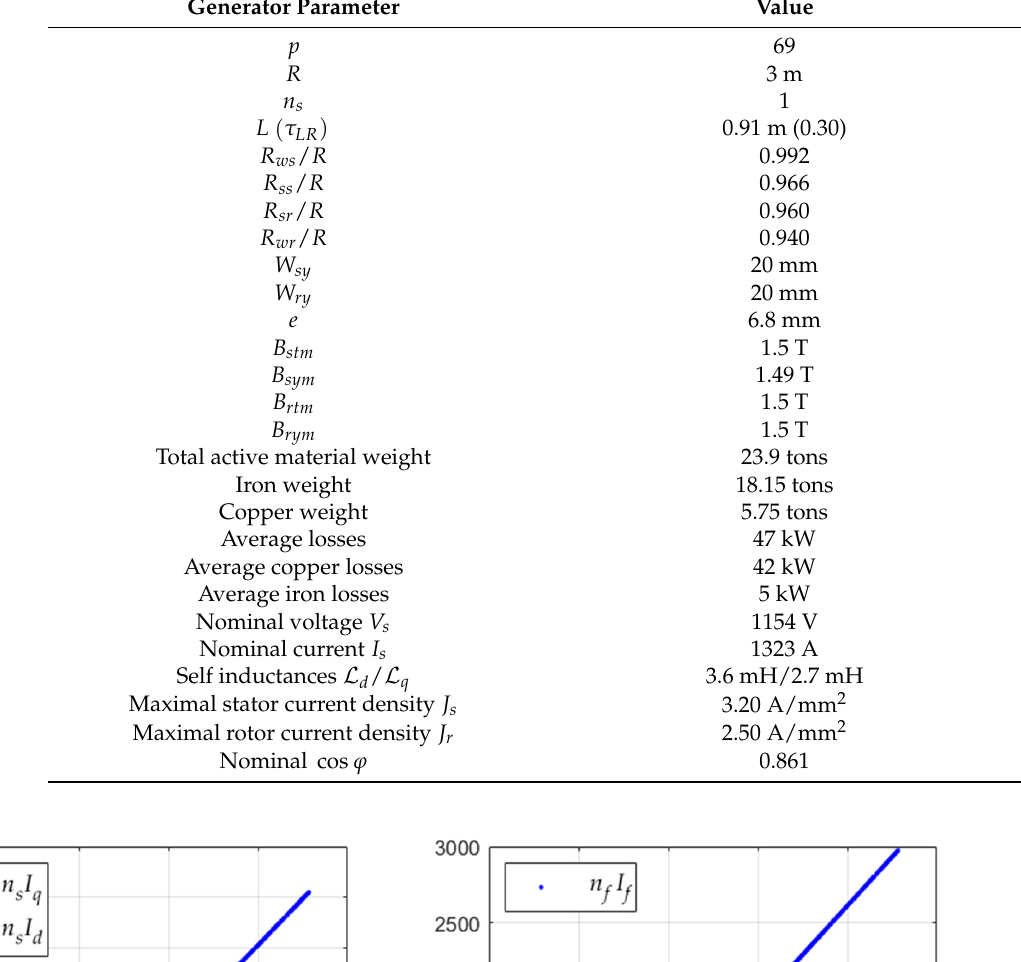
15 of 21 Table 3. Optimal generator parameters. Generator Parameter